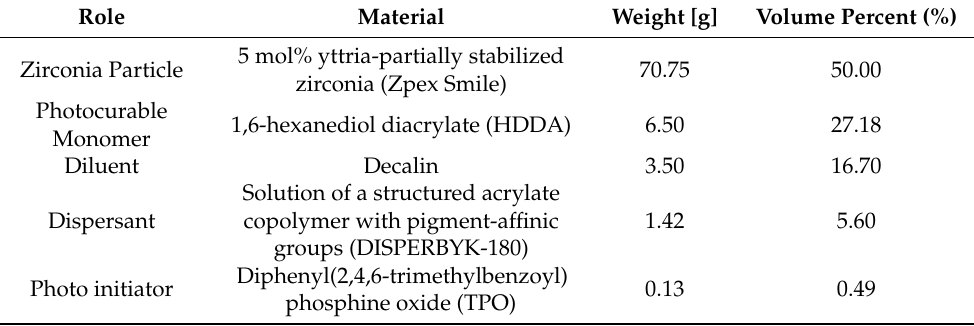
Table 1. Constituents of 5Y-PSZ suspensions with a solid loading of 50 vol% used for our DLP